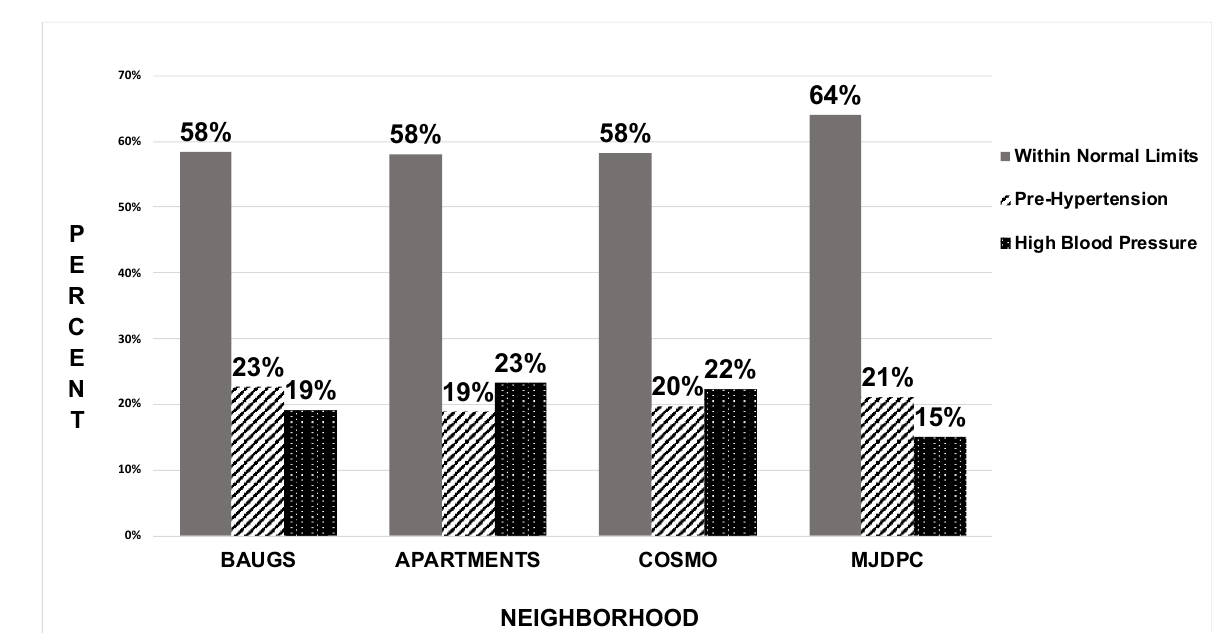
Figure 2. Blood Pressure prevalence among Parsis by neighborhood. Prevalence percentages of healthy, prehypertensive and high BPs in each neighborhood. The neighborhood cohorts are on the X -axis and BP prevalence percentages are on the Y -axis.